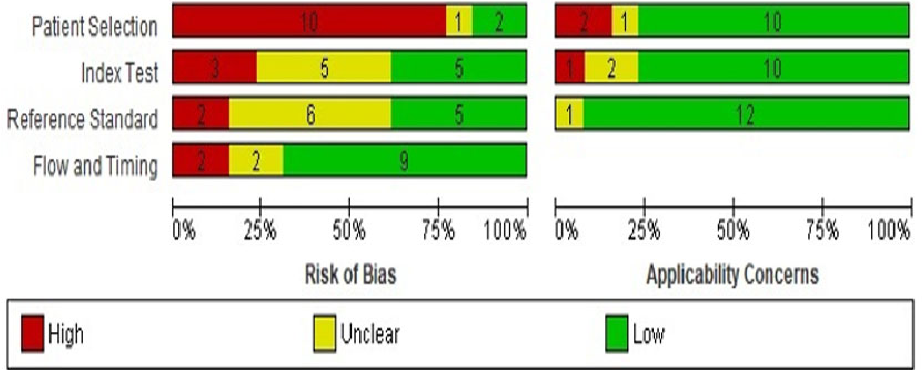
Figure 2. Summary of the risk of bias and applicability concerns.